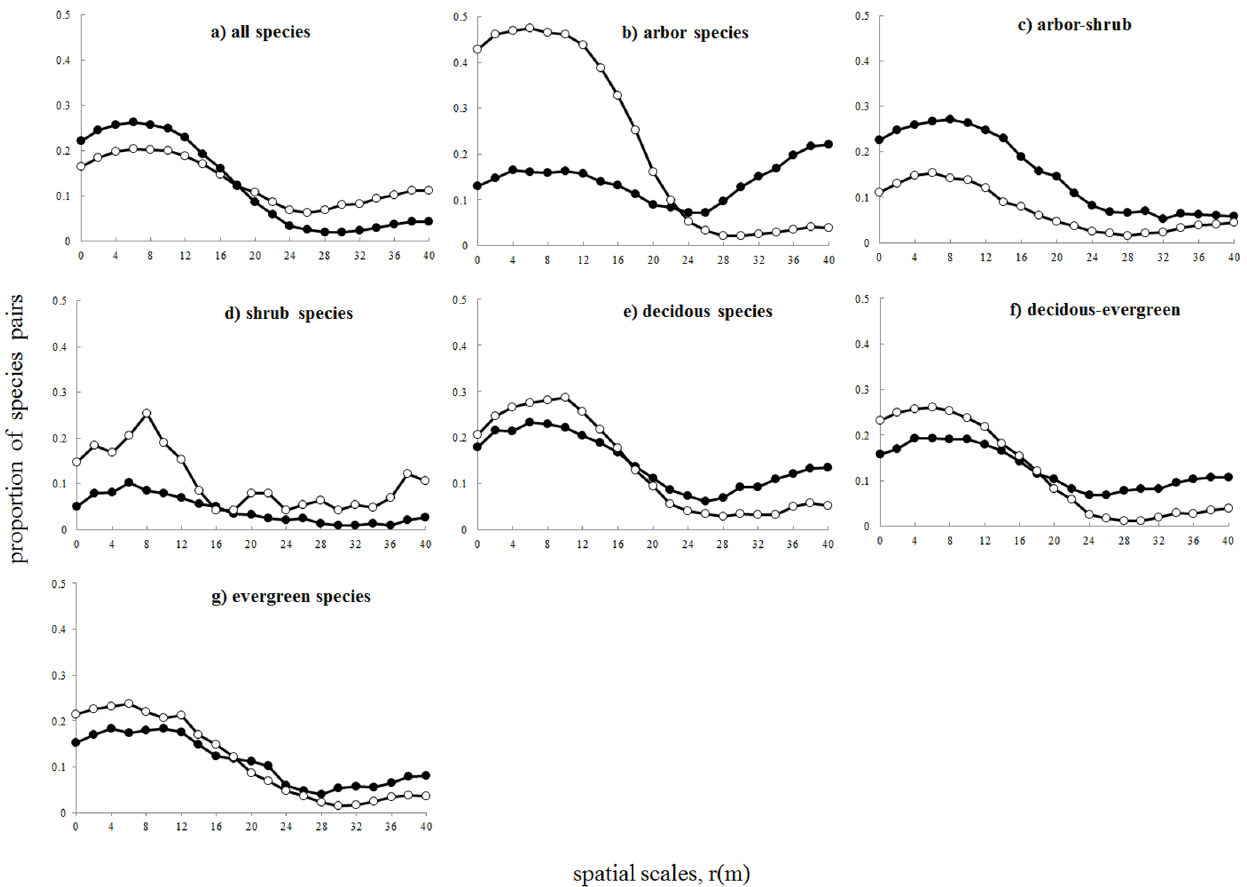
Figure 4. The proportion of significant interspecific associations for all species and different life forms at 0 2 50 m scale. a) All species, b) arbor species, c) shrub species, d) arbor-shrub species, e) deciduous species, f) evergreen species, g) deciduous-evergreen species. Figure S1 Topographic map in 25-ha Badagongshan Forest Dynamic plot (after Wang et al. unpublished data). Figure S2 Example for analysis of the fine-scale species interaction for species pairs of arbor and shrub. Figure S3 Species abundance distribution for 31 arbor species and 20 shrub species in this study. Table S1 Species properties for 51 species in this study.